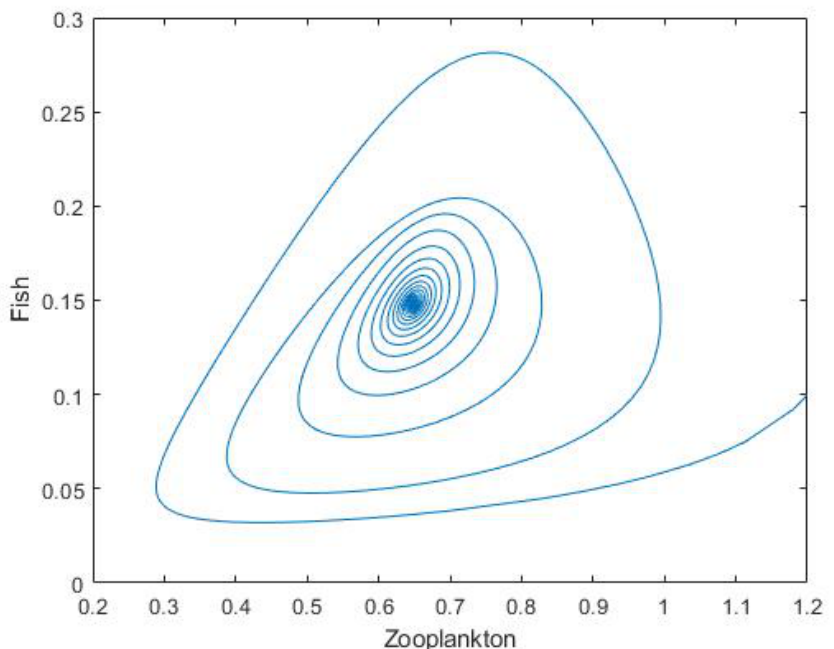
Figure 15. The asymptotical stability between the zooplankton and fish populations for τ = 0.